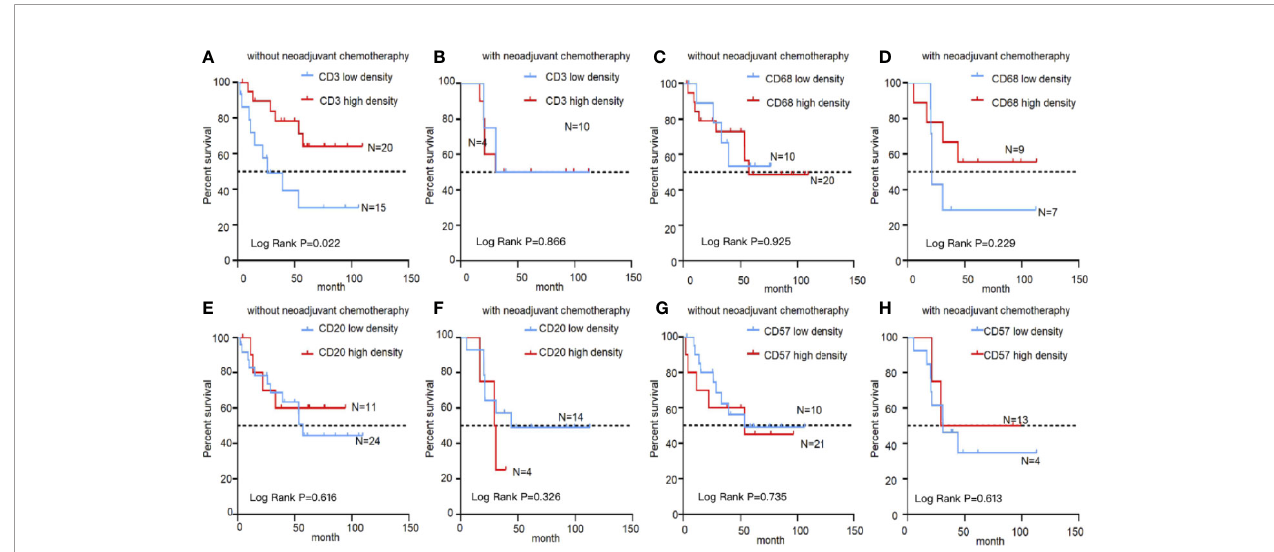
FIGURE 4 | Kaplan – Meier survival curves showing in fi ltration of immune cells in EBVaGC with or without chemotherapy. Analysis of EBVaGC patients strati fi ed by CD3 + T lymphocyte density (A) without and with (B) neoadjuvant chemotherapy, CD68 + macrophages without (C) and with (D) neoadjuvant chemotherapy, CD20 + B lymphocytes without (E) and with (F) neoadjuvant chemotherapy, and CD57 + NK cells without (G) and with (H) neoadjuvant